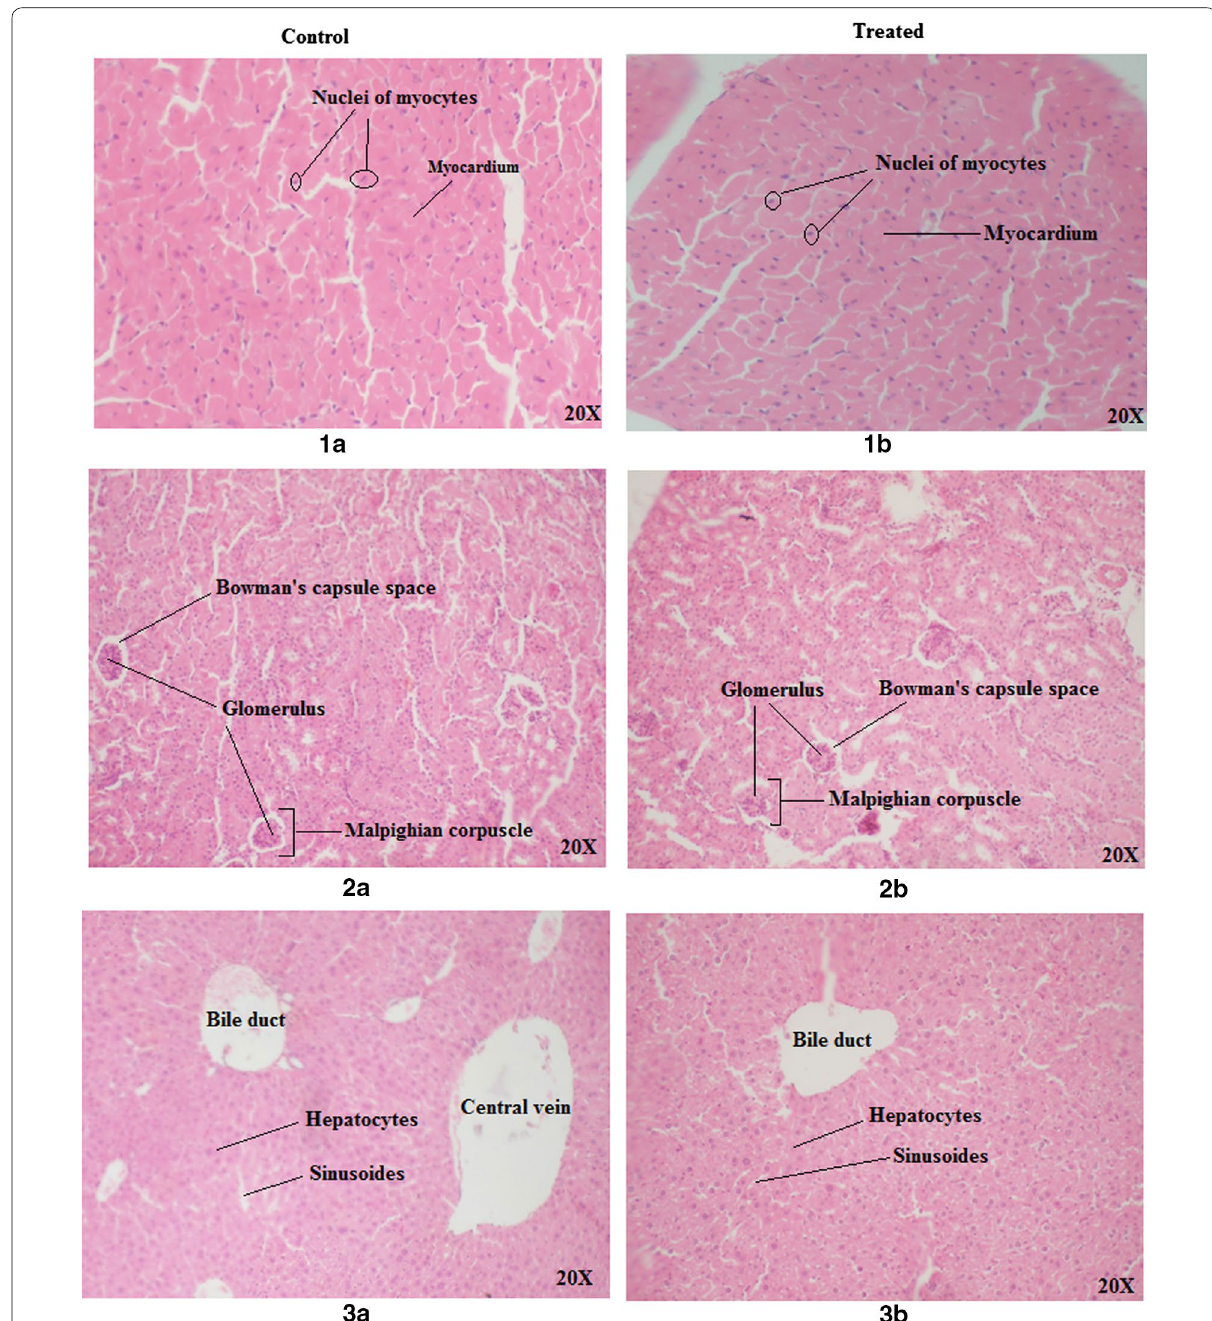
Fig. 6 Photomicrographs of the tissue sections of ( a ) heart ( b ) kidney and ( c ) liver taken from mice treated with Berberis aristata diterpenes for 14 days for assessment of acute oral toxicity in comparison with untreated